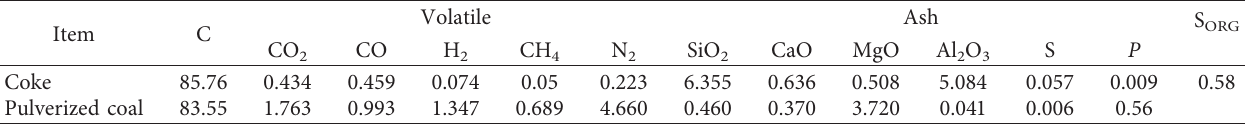
Table 3: Main chemical composition of fuel.